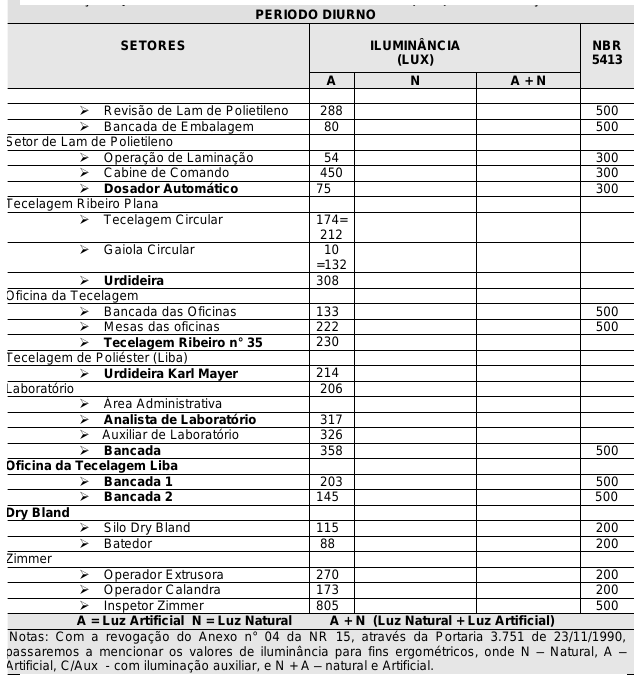
Tabela 4: Avaliação Quantitativa de Níveis de Iluminância (LUX) – Segurança n° 03 Período